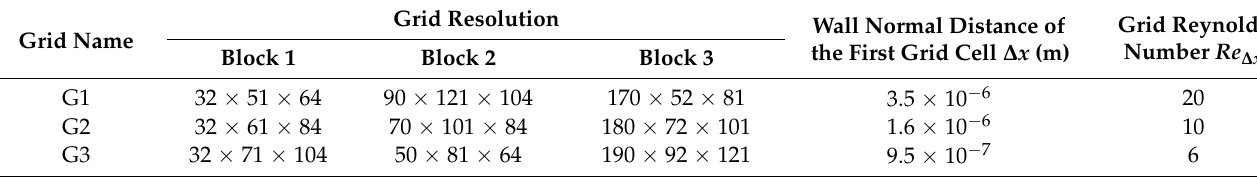
Figure 2. HIFiRE-5 configuration fixed on a 2 mm long aerodisk.